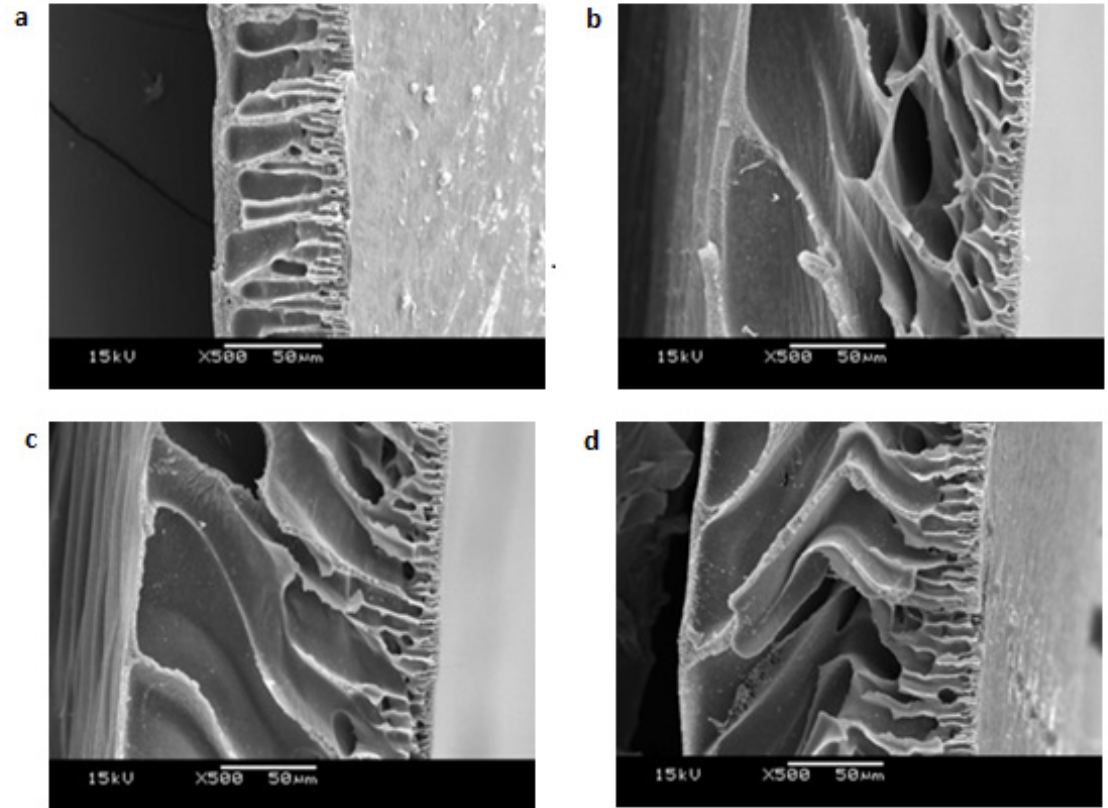
Figure 3. Morphology structure of PVC membrane on transverse part at PF127 concentrations of 0% ( a ); 3% ( b ); 5% ( c ); and 7% ( d ). Each image is representative of n=3 scanning electron microscopy images.